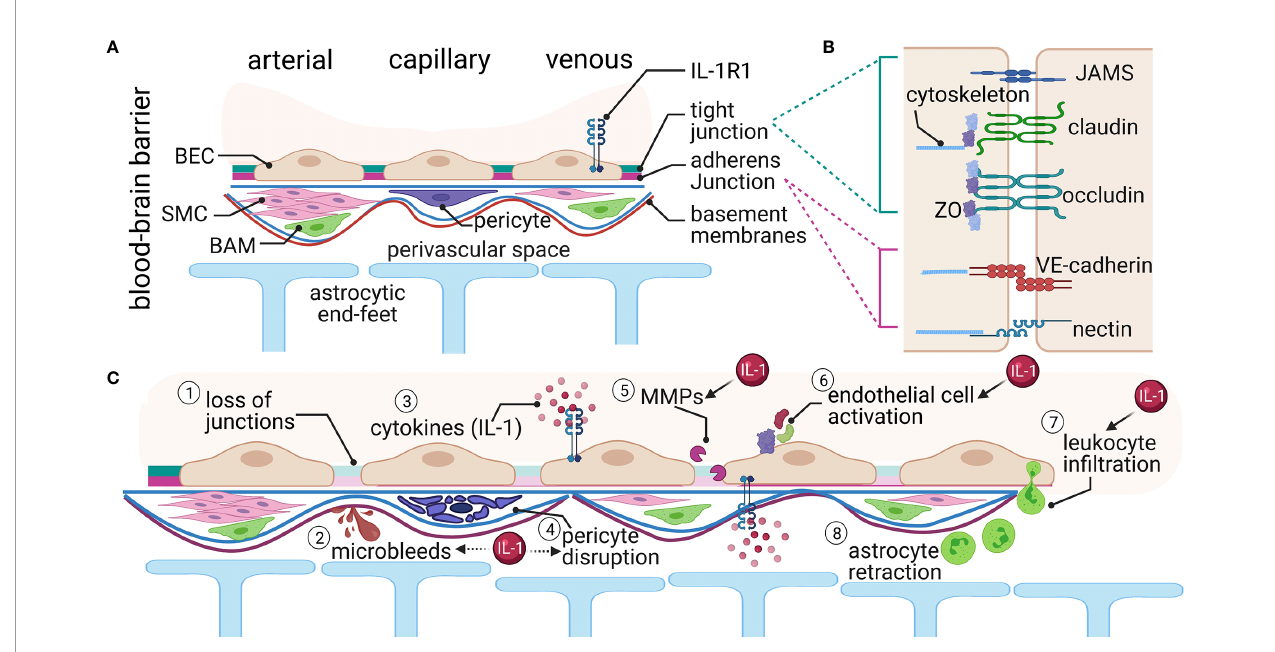
FIGURE 1 | The Blood Brain Barrier (BBB). (A) Brain endothelial cells (BEC) form the fi rst layer of the BBB. An endothelial basement membrane then surrounds the BECs. Smooth muscle cells (SMC), pericytes, and border-associated macrophages (BAM) are in the next layer. Finally, the parenchymal basement membrane and the astrocytic end-feet create the perivascular space. Interleukin-1 receptor 1 (IL-1R1) is expressed in the venous compartment of the BECs, presumably on both the luminal and abluminal sides. (B) The junctions between endothelial cells form the major barrier component and consist of several proteins both in the intercellular space and intracellular compartments. (C) Traumatic brain injury causes several alterations at the BBB. These changes include (1) loss of junctional proteins, (2) microbleeds, (3) local and systemic increased cytokines, (4) pericyte disruption, (5) matrix metalloprotease (MMP) activation, (6) endothelial cell activation, (7) leukocyte in fi ltration, and (8) astrocyte retraction from the barrier. Many of these changes have been linked either directly (solid arrow) or indirectly (dashed arrow) with IL-1